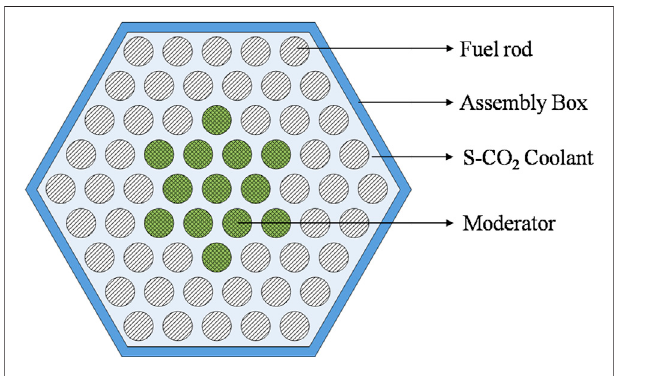
FIGURE 12 | Optimized design of S-CO 2 fuel assembly with